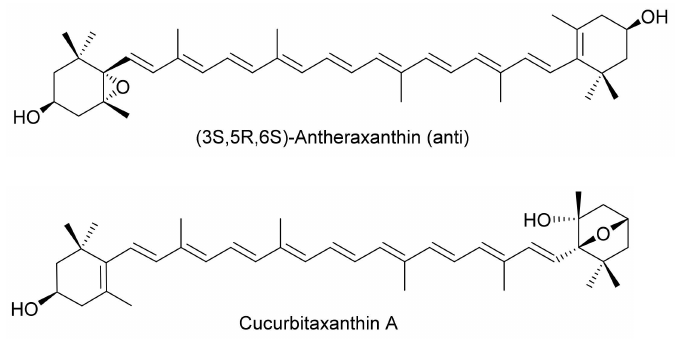
Figure 5. Structures of antheraxanthin and cucurbitaxanthin